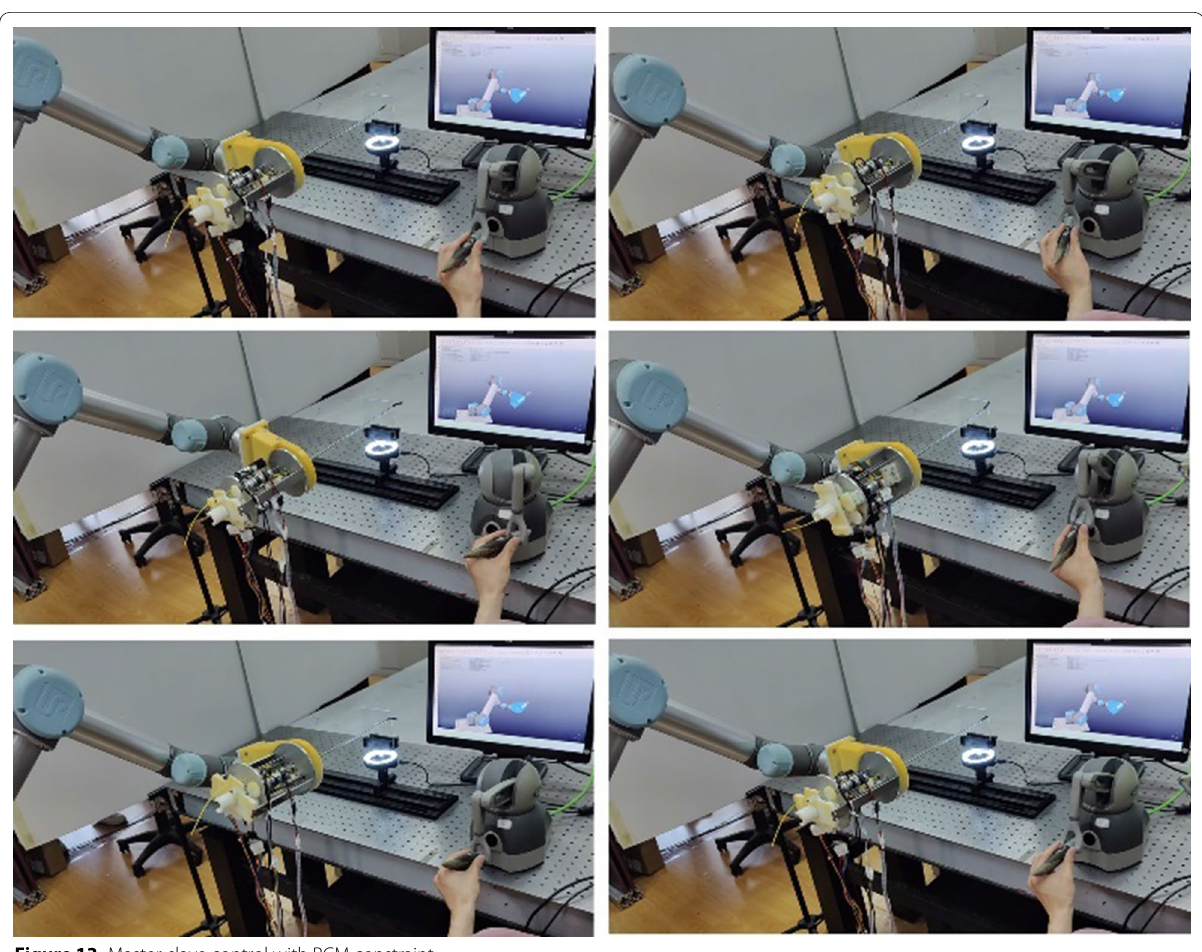
Figure 13 Master-slave control with RCM